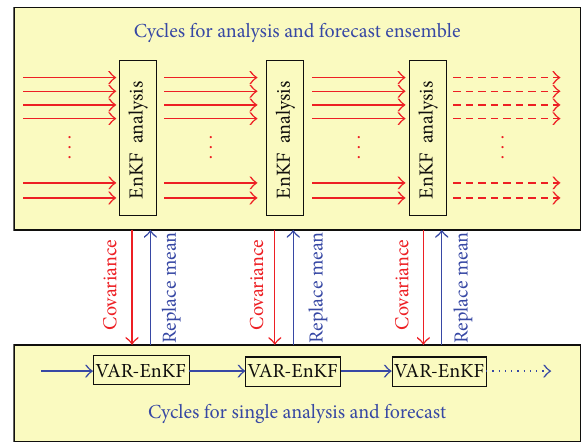
Figure 1: Illustration of cycle used in a hybrid EnKF-3DVAR analysis